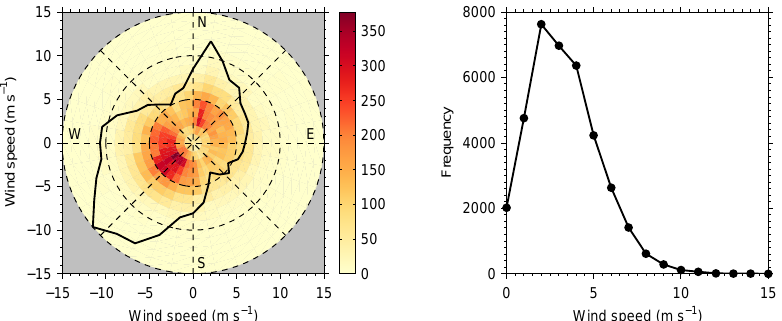
Figure 10. Wind rose showing the wind speed and wind direction using hourly data from an automatic weather station located approximately 21km to the west of the weather radar for the period April 2010–December 2013. The figure to the left shows the distribution of wind speed and wind direction. The solid black line shows the wind direction for all wind speeds. The figure to the right shows the distribution of wind speed for all wind